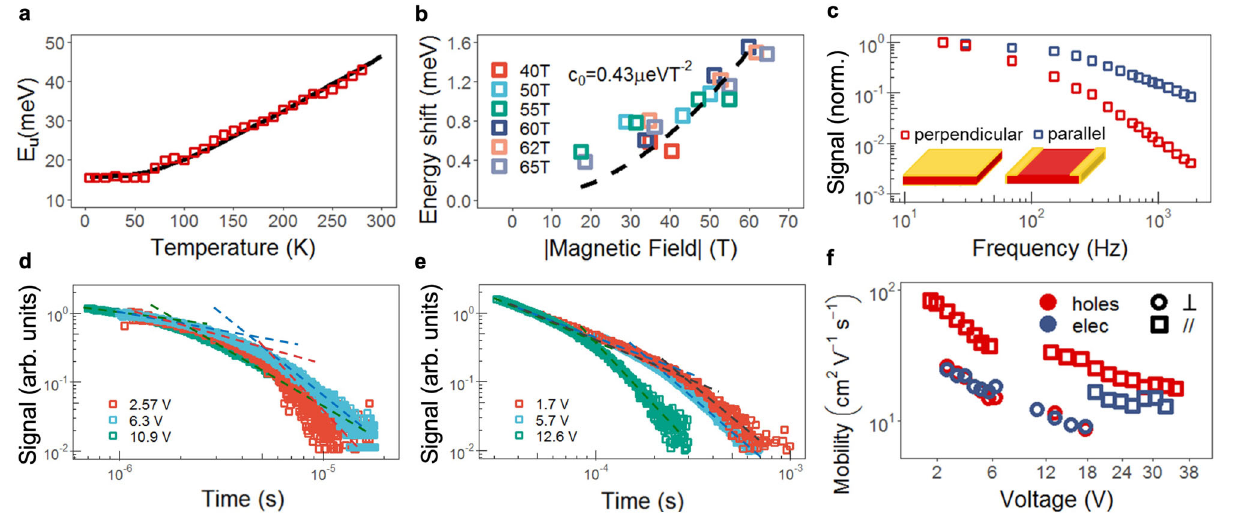
Fig.3|PhotophysicalpropertiesinBiOI.a TheUrbachenergy( E U )asafunctionof temperature, determined from transmission experiments. b Measured change in absorption edge as a function of magnetic fi eld strength (colours correspond to different applied fi elds, key shown inset). Dashed line indicates parabolic fi t through the data, with fi tted scaling constant c 0 as depicted. c Normalised pho- tocurrent obtained using a lockin-ampli fi er (excitation from 3.06eV cw laser) as a functionofchoppingfrequencyforboththeparallel(darkblue)andperpendicular devices (red). Device structures inset. d , e Normalised transient current curves of